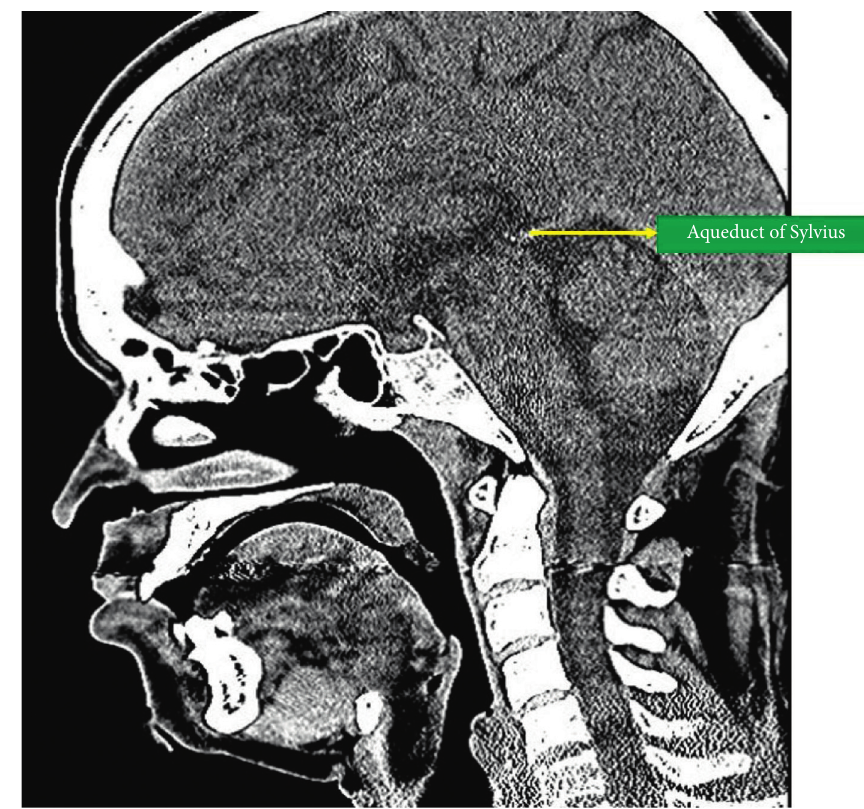
Figure 1: The aqueduct of Sylvius in the 2D midsagittal CT